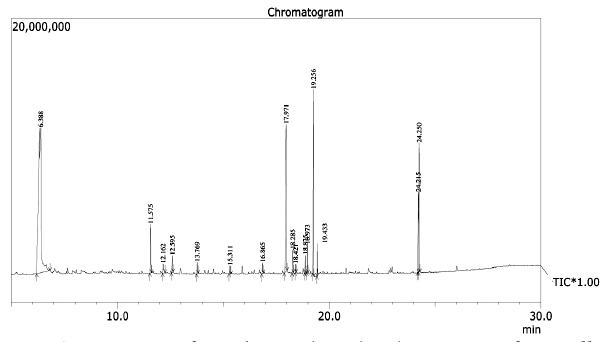
Fig. 4. GC-MS of crude methanol ink extract of Sepiella